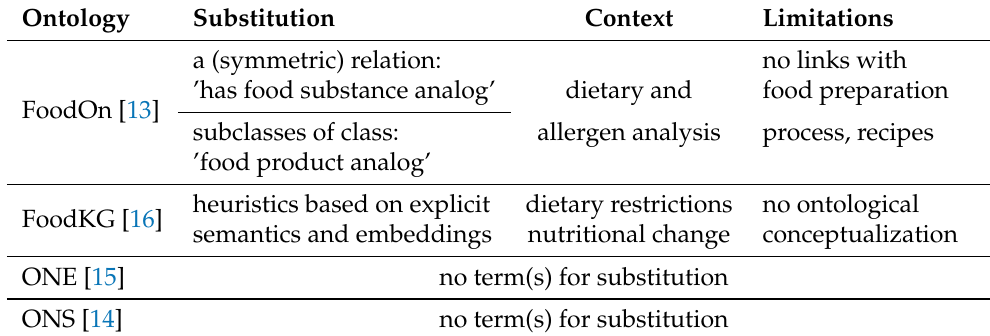
Table 1. Conceptualization of substitutions in existing ontologies and knowledge graphs.